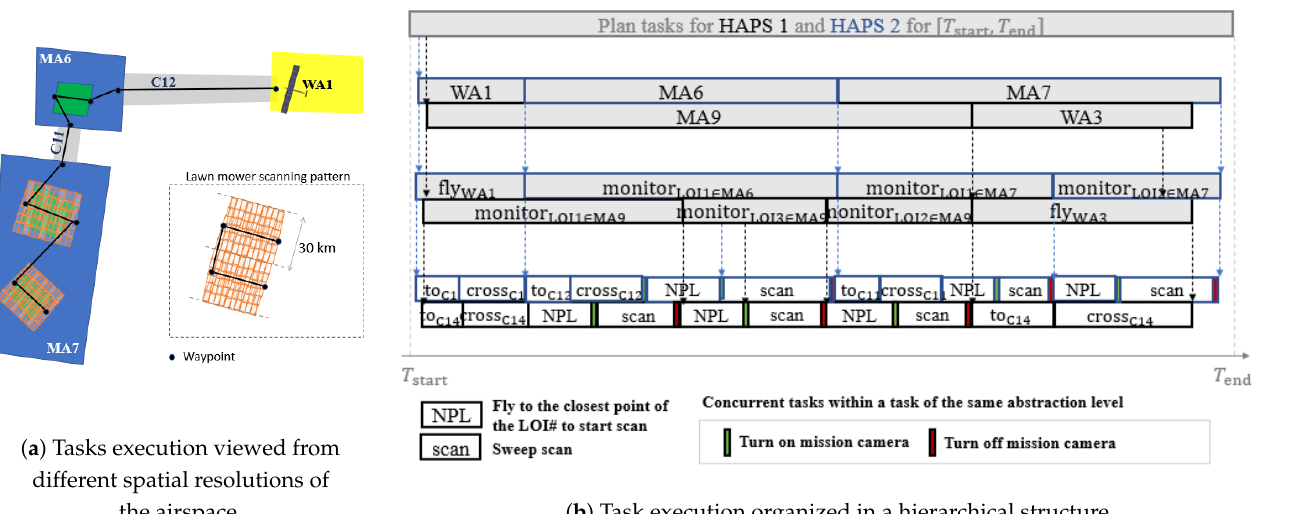
Figure 2. Hierarchical task execution for